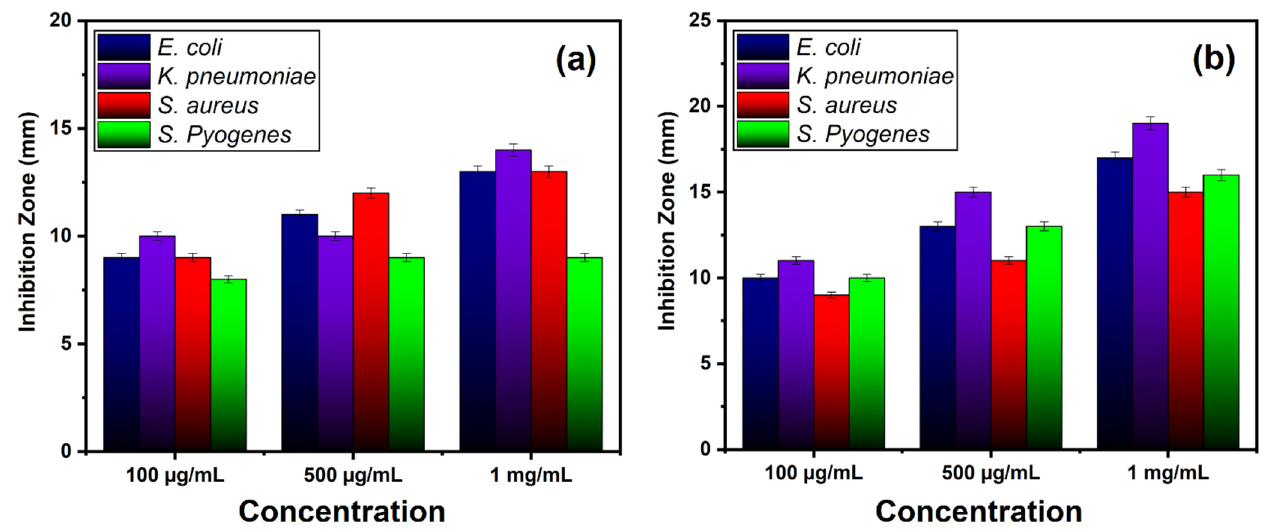
Figure 10. Zone of inhibition (ZOI) formed by Co-doped ZnO microcrystals against different bacte- ria.